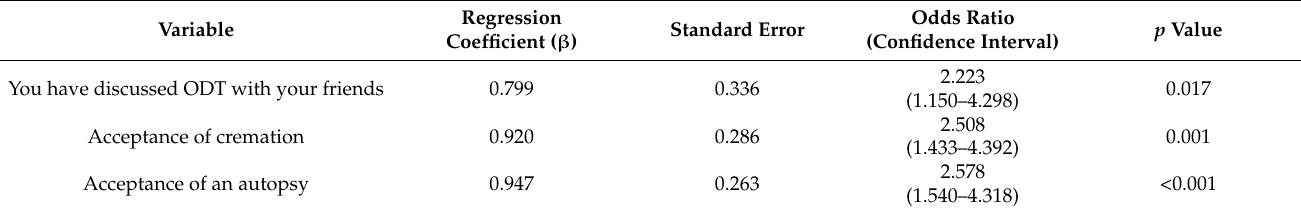
Table 5. Multivariate